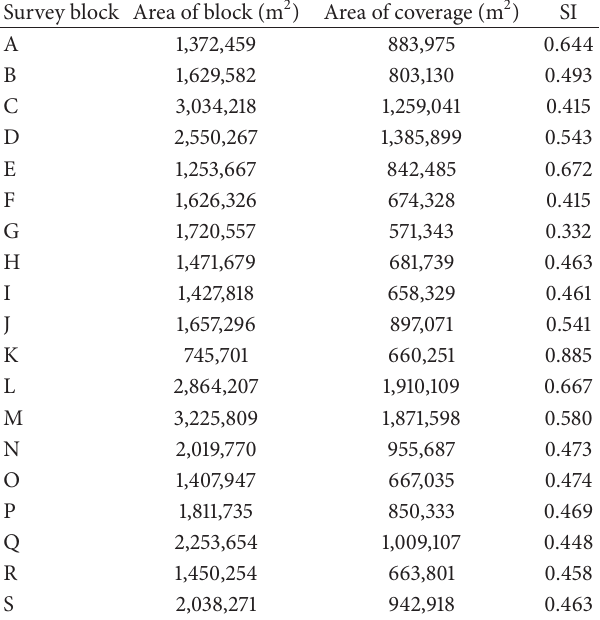
Table 2: Area of block (m 2 ), area of coverage (m 2 ) based on 350 m visual swath width, and survey intensity (SI) of each survey block